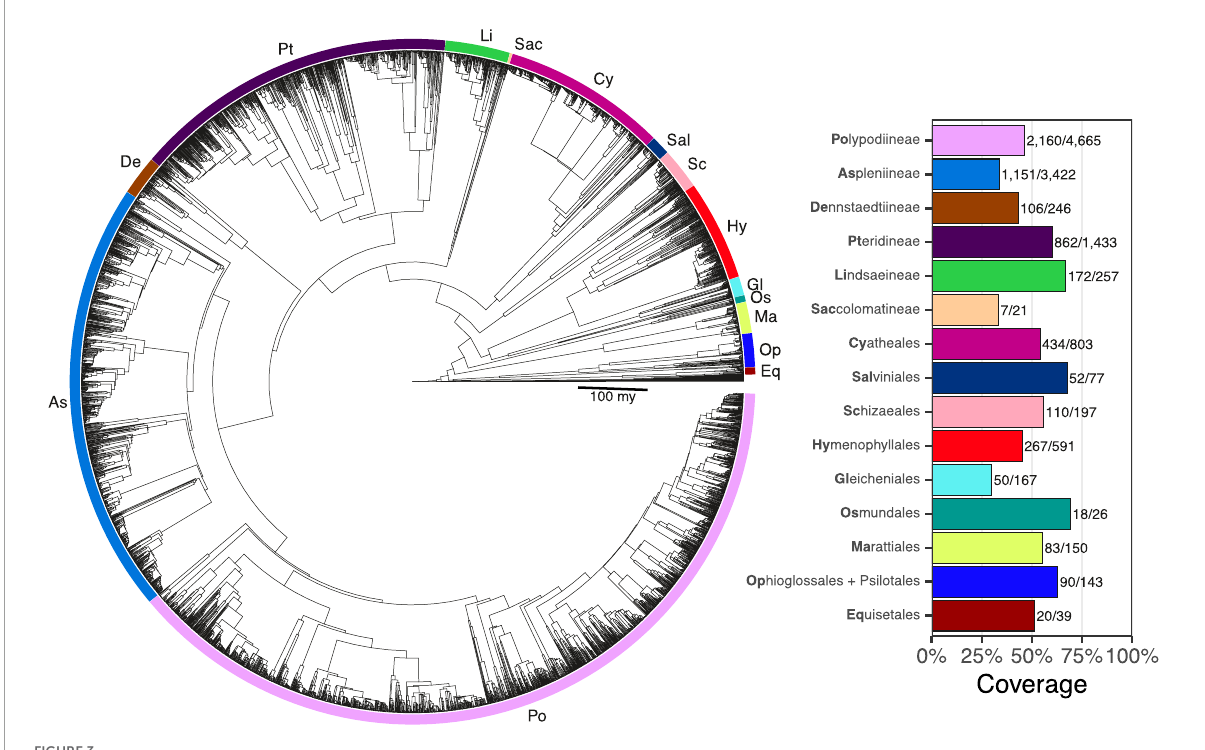
FIGURE3 Fern tree of life (FTOL). Tree rooted with algae. Inset plot shows coverage by major clade (order or suborder). Bold part of each clade name is its code, which is also indicated on the tree. Numbers next to each bar show sampled species out of total number of species. Taxonomy follows Pteridophyte Phylogeny Group I